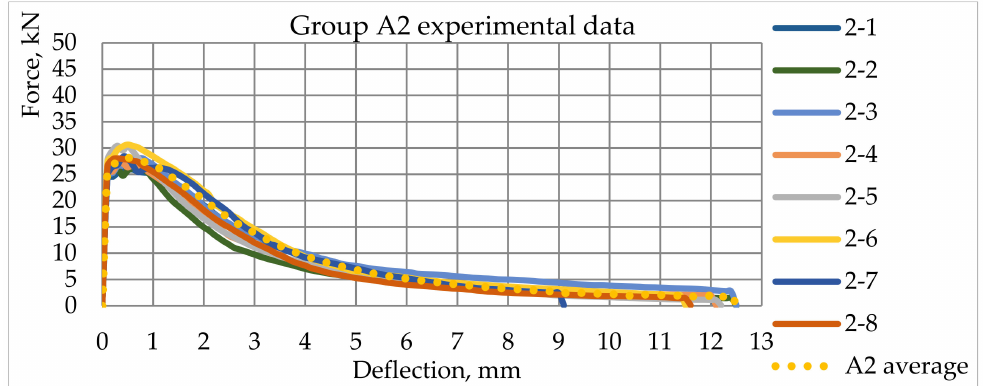
Figure 16. Load—sample center vertical deflection graphs for the specimens in Group A2.